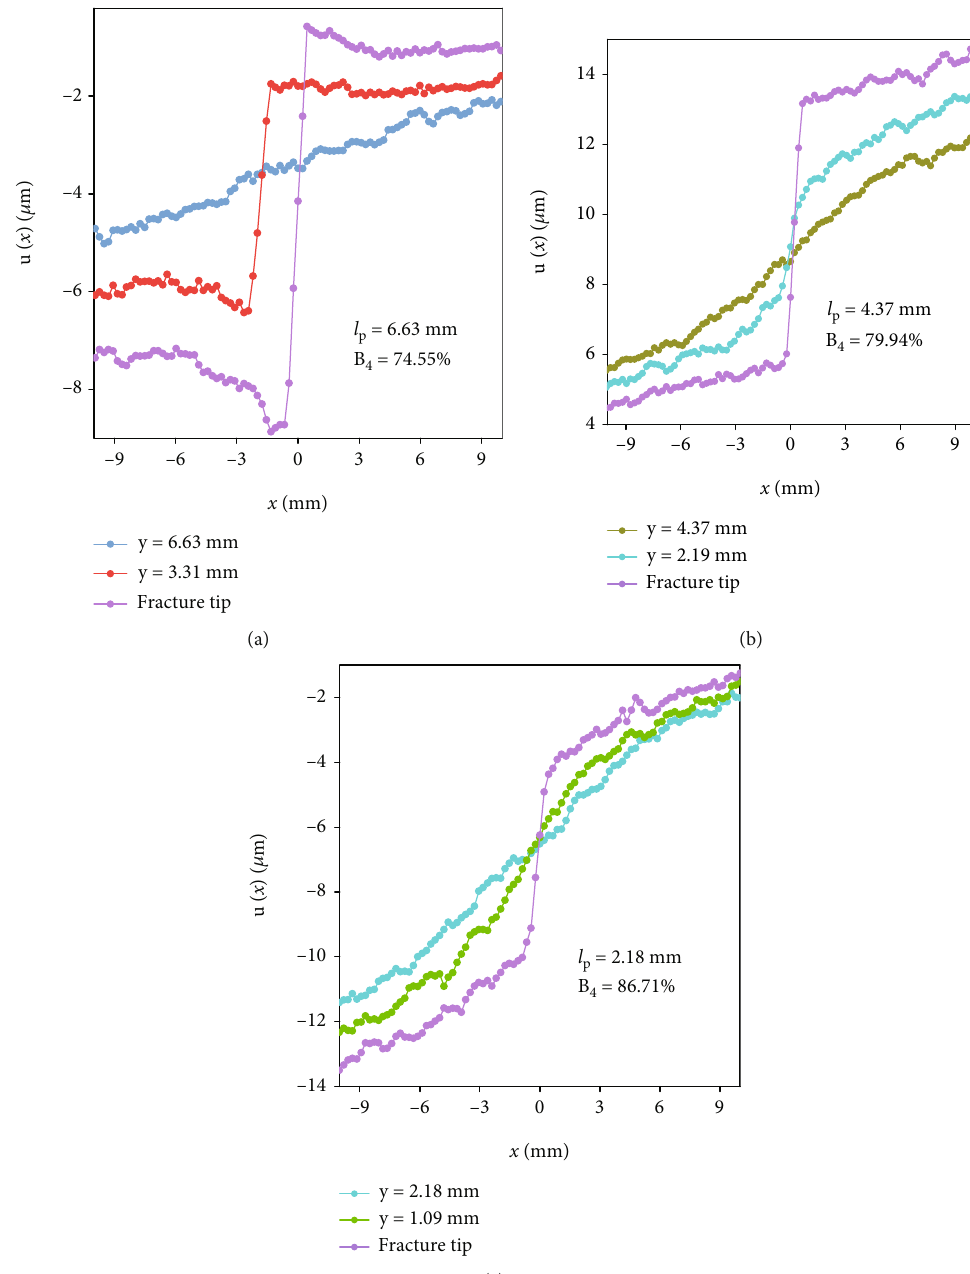
Figure 11: Characterization of the length of fracture process zone in di ff erent brittle